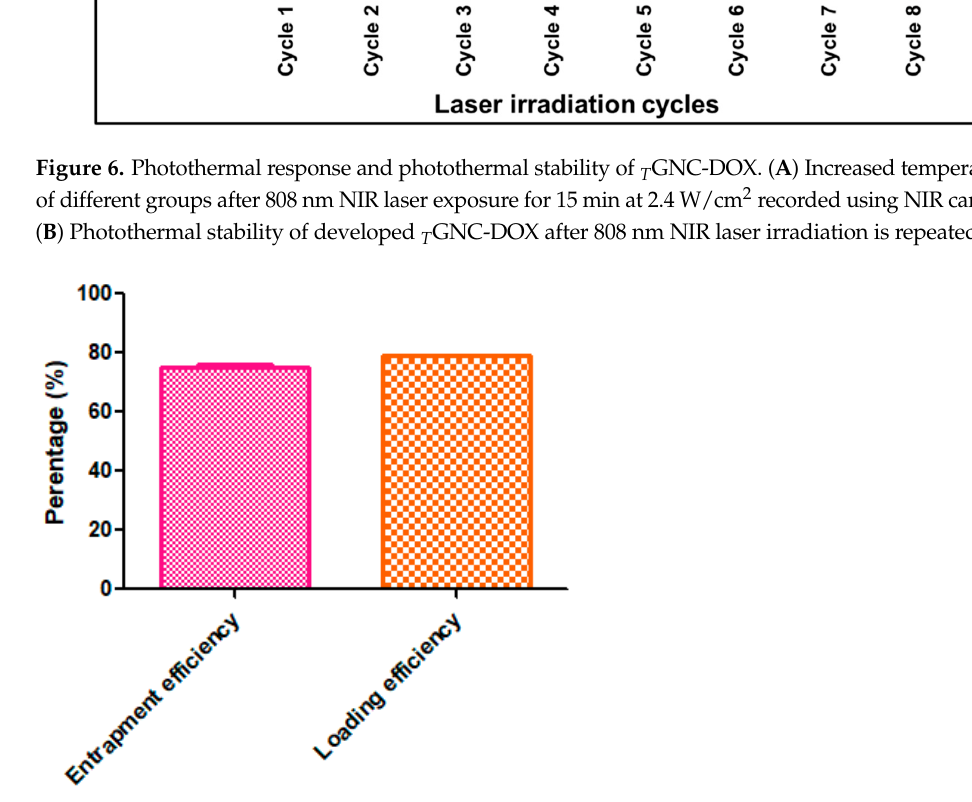
Figure 7. Percentage entrapment efficiency and loading efficiency of DOX in developed T